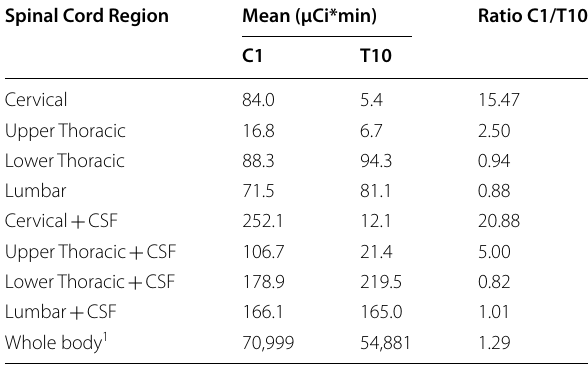
Table 2 Mean tracer concentrations by spinal region and ratio of concentrations by catheter tip